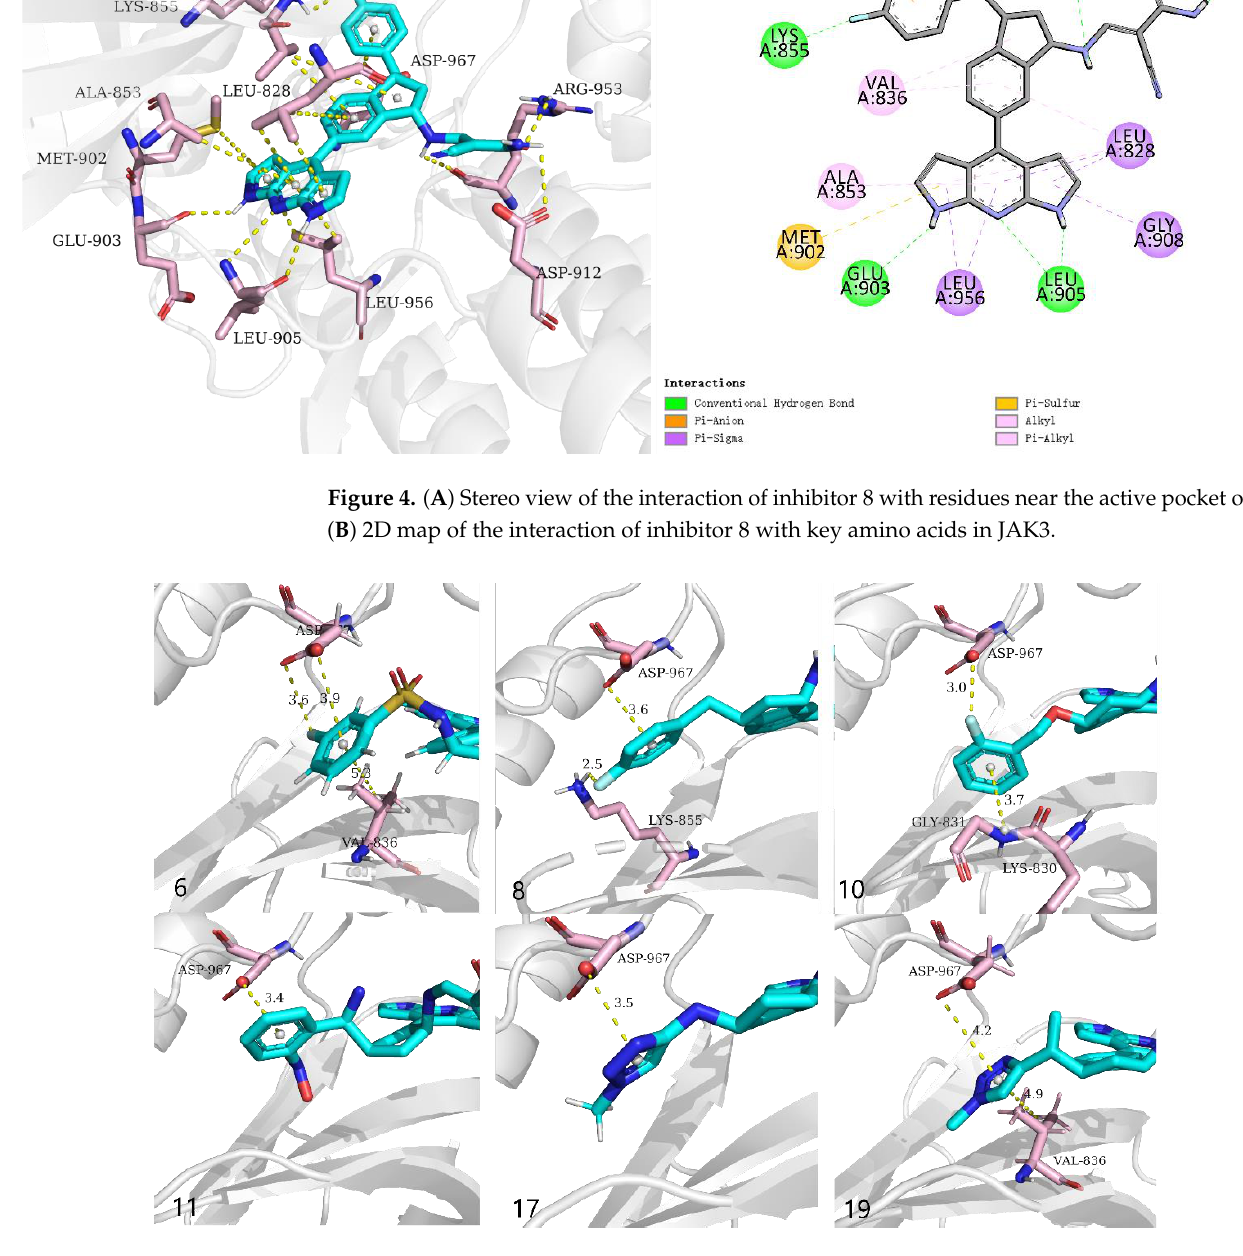
Figure 5. Three-dimensional map of the binding pattern of the R group of inhibitors 6, 8, 10, 11, 17, 19 to the active pocket of JAK3.